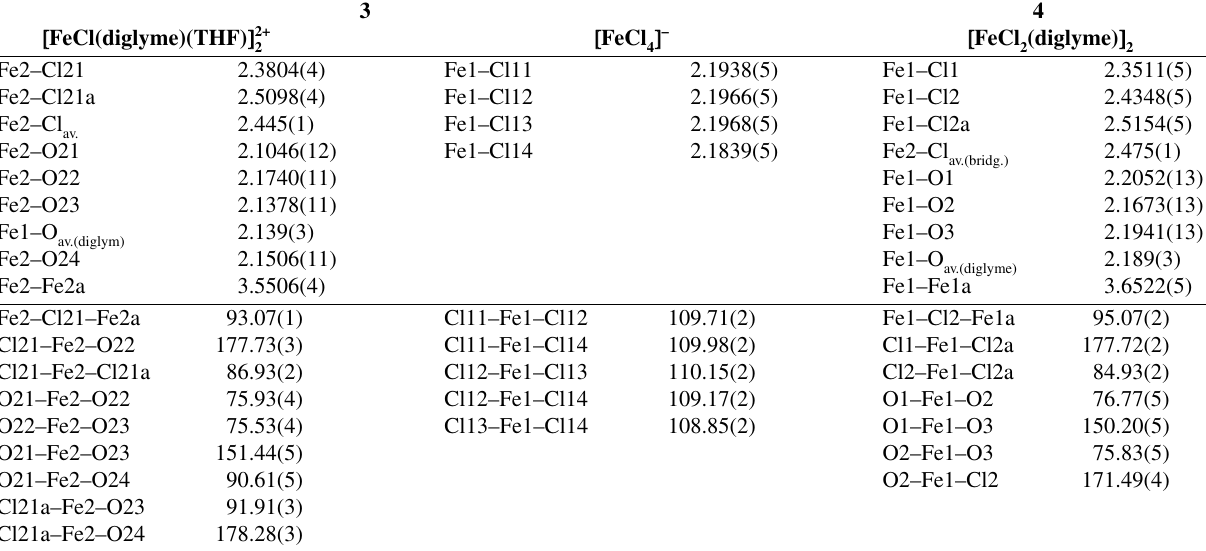
[ FeCl ] ,and 4 , [ FeCl 2 4 2